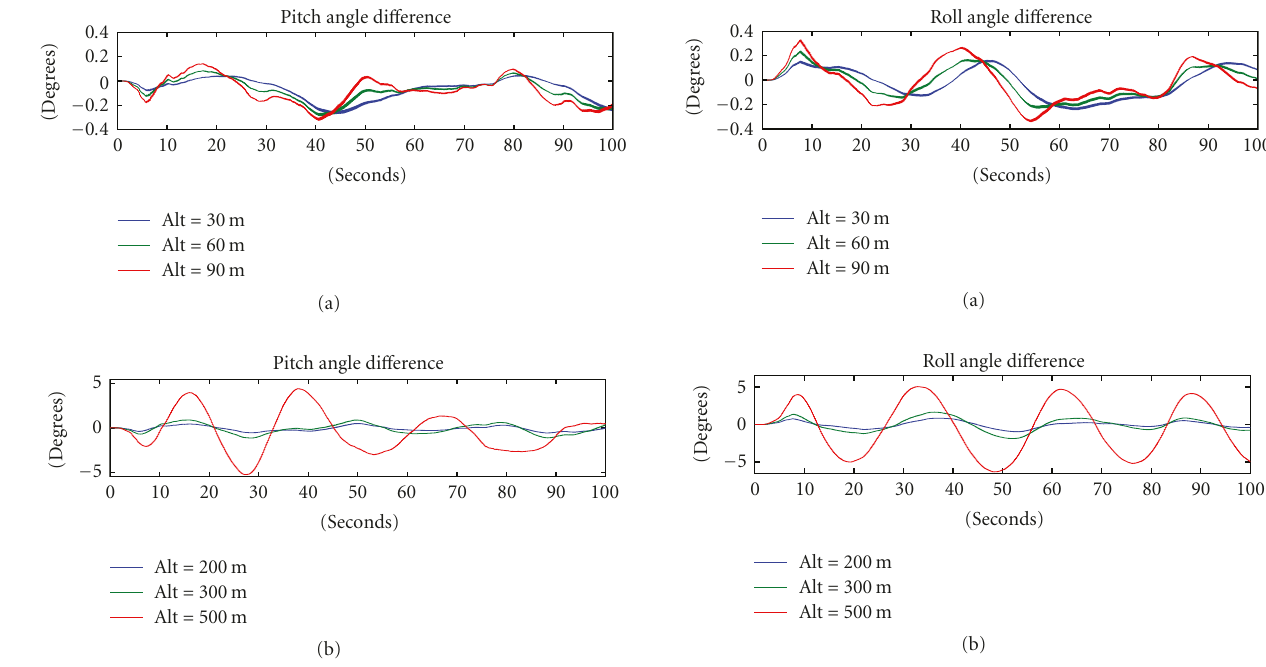
Figure 7: Di ff erence between the pitch angle estimated by the KF with a constant position update and the KF updated using odometry position. It can be noticed how the increasing of the flight altitude makes the oscillatory behavior of the system more evident with an increasing in amplitude.